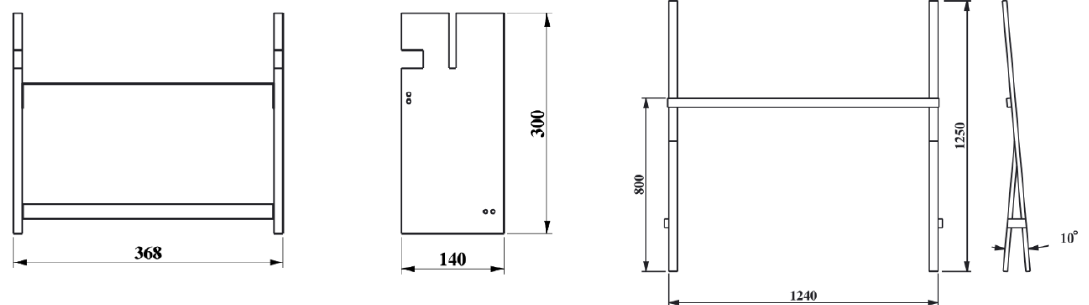
Figure 4. The support frame (left and middle picture for automotive and right one for aviation setup).